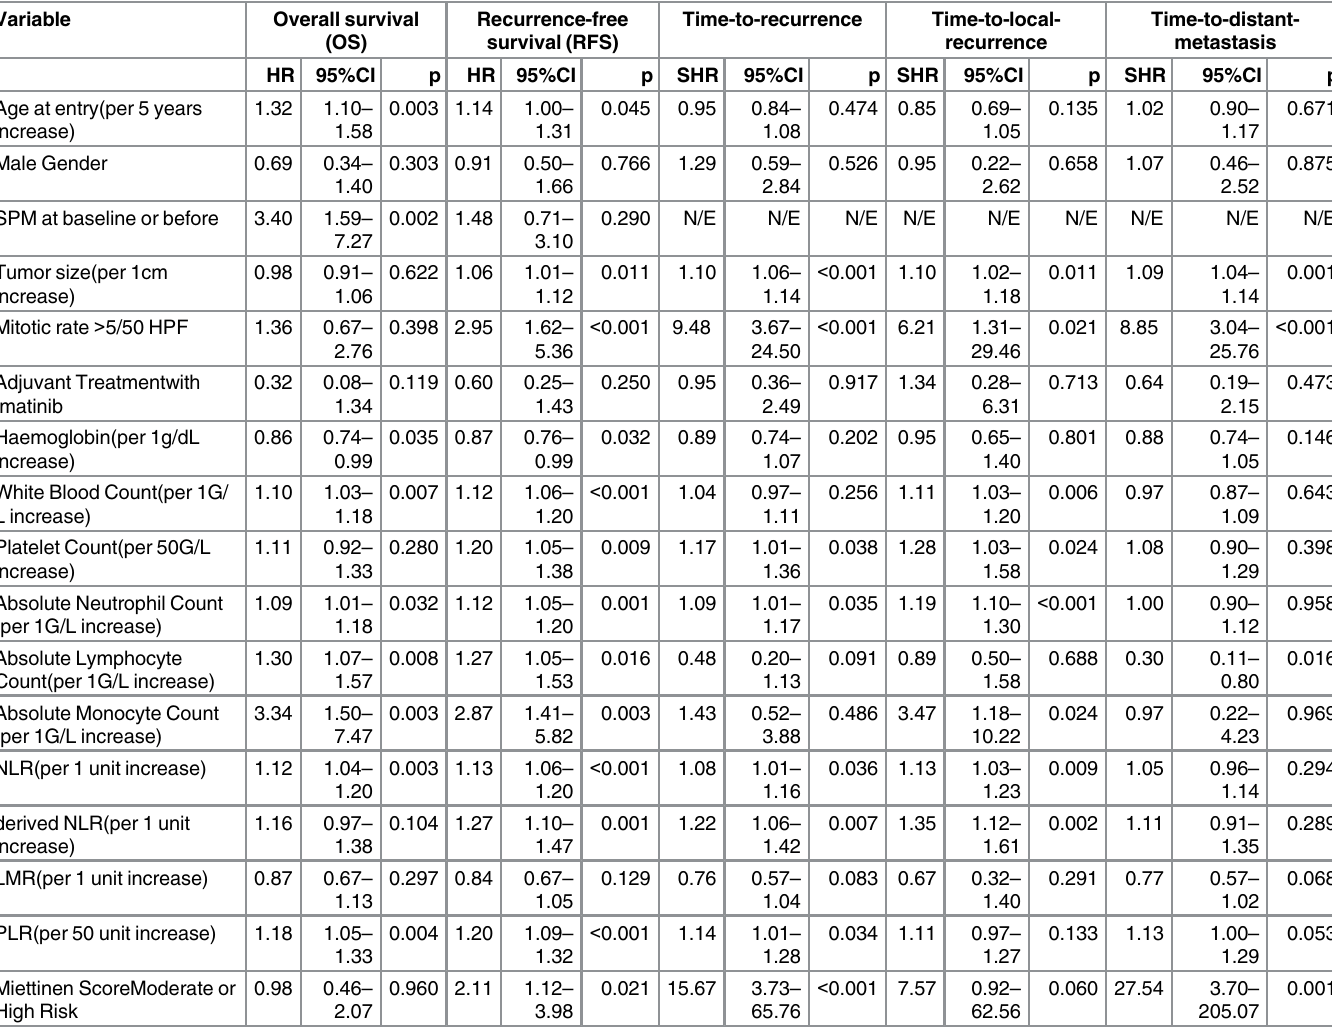
Table 2. Baseline Predictors of Oncologic Outcomes in GIST – Univariable Analysis. The endpoints overall survival and recurrence-free survival were analyzed with Cox proportional hazards models, whereas the endpoints local recurrence, distant metastasis, and recurrence were analyzed using Fine & Gray models. Abbreviations: HR – hazard ratio, SHR – subdistribution hazard ratio, 95%CI – 95% confidence interval, p – p-value, HPF – high power field, g/dL – grams per deciliter, G/L – giga per liter, NLR – neutrophil lymphocyte ratio, dNLR – derived NLR, LMR – lymphocyte monocyte ratio, PLR – platelet lymphocyte